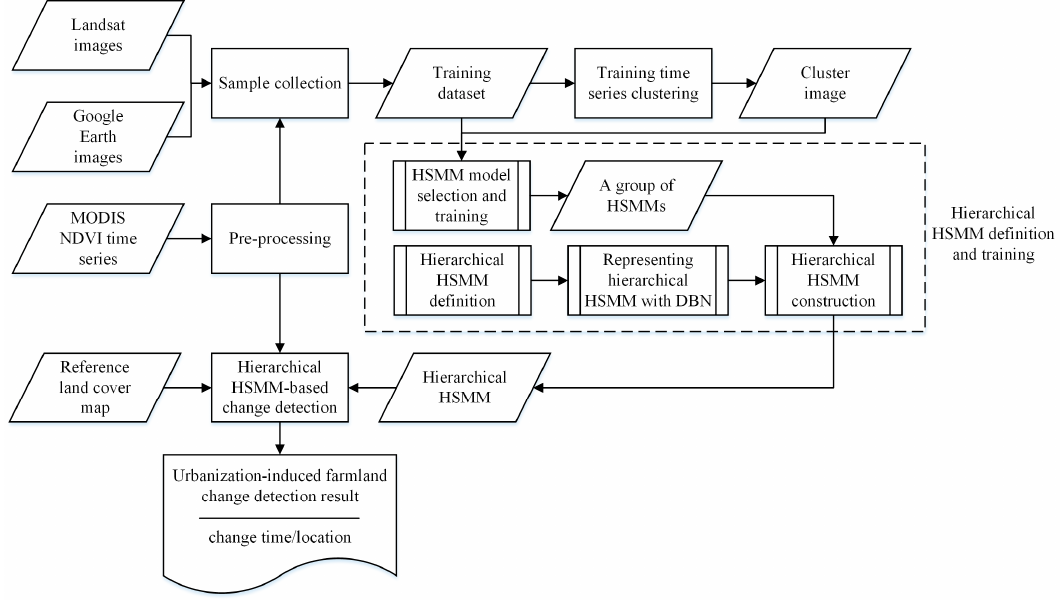
Figure 5. Flowchart of the proposed algorithm.